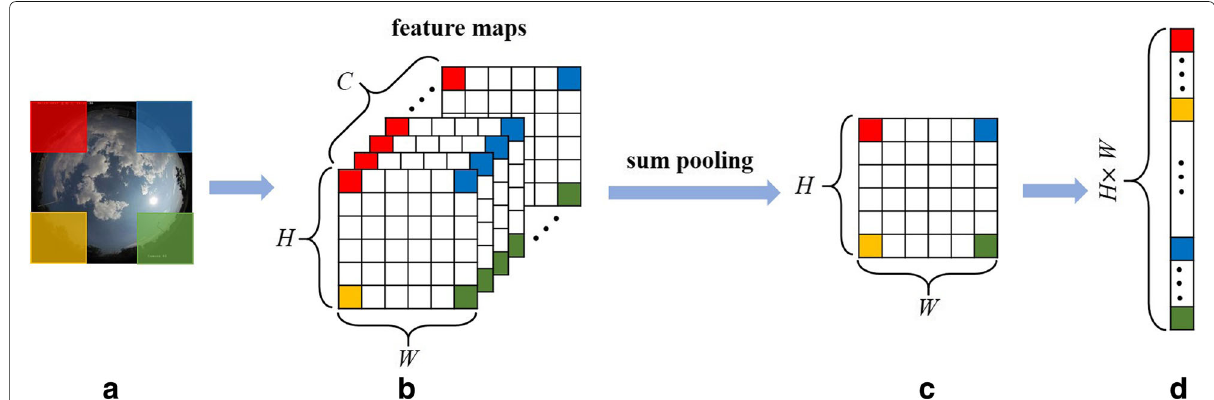
Fig. 2 The sum pooling strategy for feature maps in a convolutional layer. a Input cloud image. b Feature maps of a certain convolutional layer. c The SCM feature. d The feature vector for a cloud image